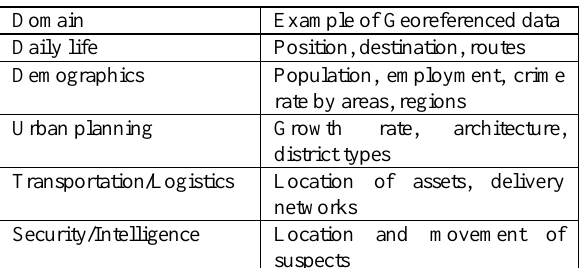
Table 1. Georeferenced data present in various